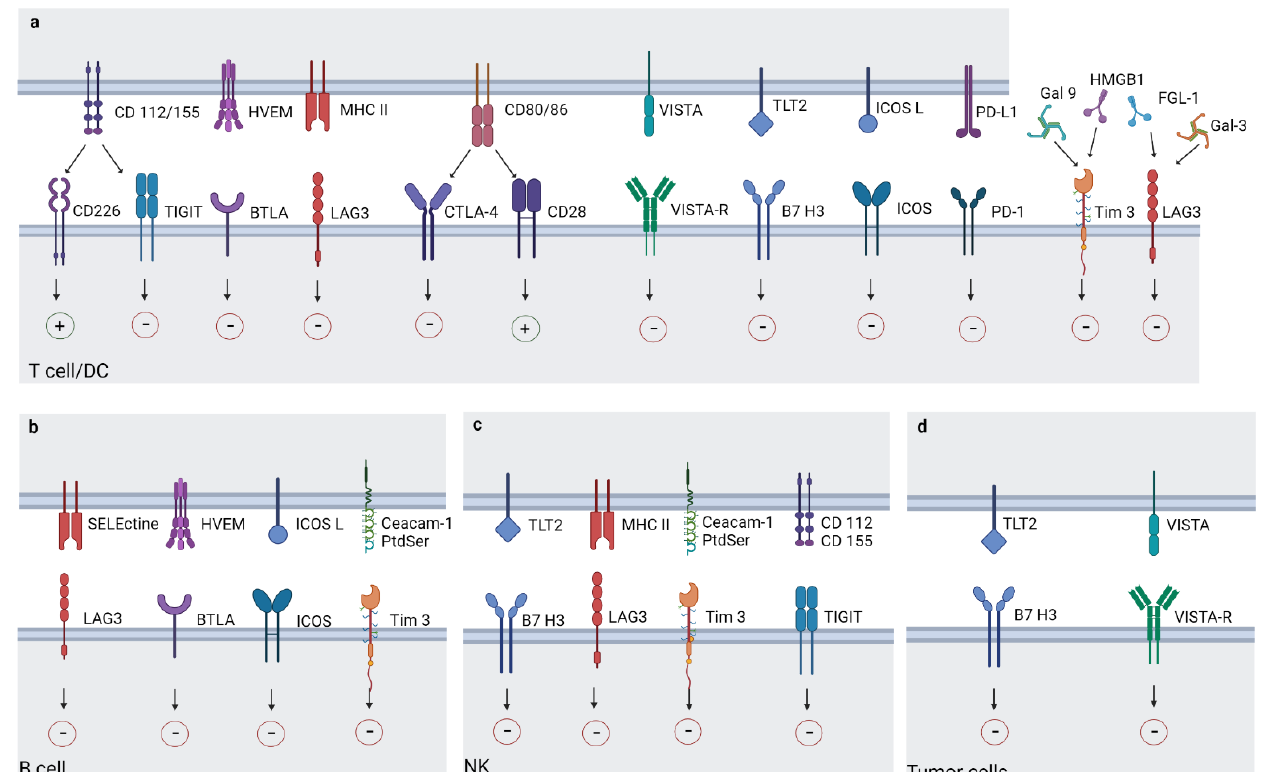
Figure 2. Expression of immune inhibitory checkpoints on different immune cells and tumor cells. Various immune checkpoints expressed by T cells and DC ( a ), B cells ( b ), B cells and NK ( c ), NK ( d ) and tumor cells. The figure shows the ligand for inhibitory receptors discussed in the review, the eventually co-stimulatory receptors activated by the ligands, and the contradictory or undefined roles of some of these molecules. Dendritic cells, (DC); natural killer, (NK); lymphocyte activation gene-3, (LAG-3); T cell immunoglobulin and mucin-domain containing-3, (TIM-3); T cell immunoreceptor with Ig and ITIM domains, (TIGIT); V-domain Ig suppressor of T cell activation, (VISTA); B7 homolog 3 protein, (B7H3); inducible T cell costimulatory, (ICOS; B and T cell lymphocyte attenuator (BTLA). Image created with BioRender.com. and accessed on 16 May